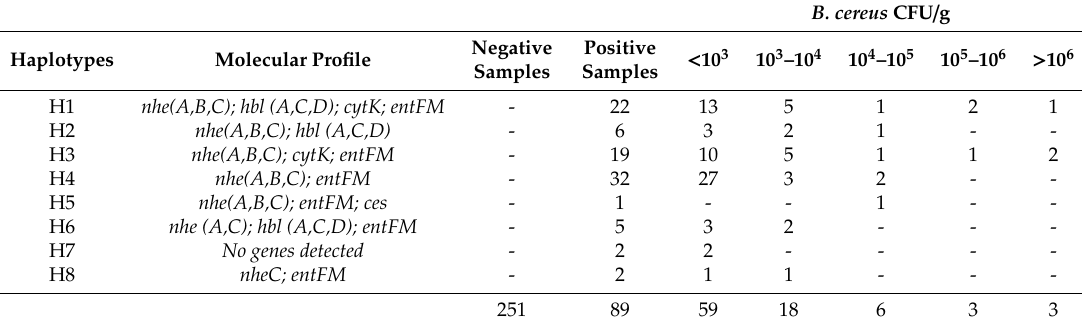
Table 2. B. cereus counts in 340 water bu ff alo mozzarella cheese (WBMC) samples and haplotypes of isolated strains. Positive samples were stratified into five classes based on the B. cereus